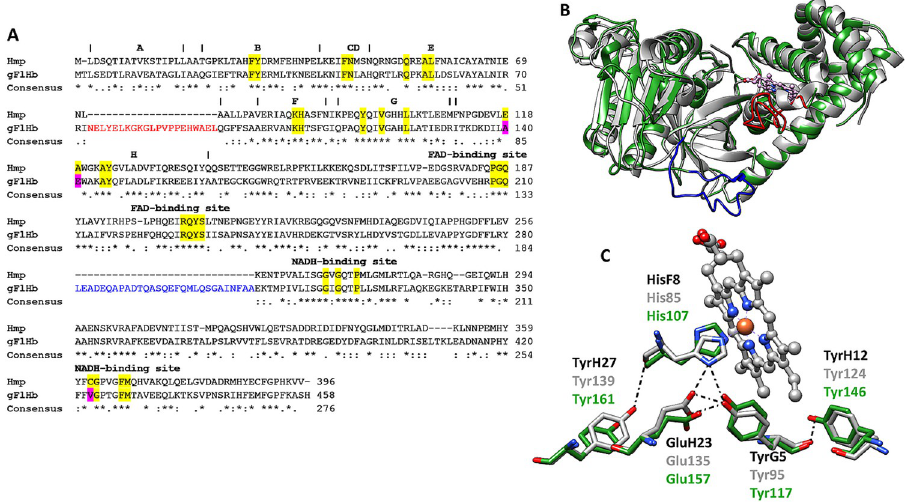
Fig 4. Sequence alignment and protein structure alignment of flavohemoglobins of G . duodenalis (gFlHb) and E . coli (Hmp). (A) Sequence alignment of gFlHb and Hmp. The conserved residues in the heme and the reductase domains are highlighted in yellow and differences present in gFlHb are highlighted in pink. The additional sequence inserts in the globin and FAD domains in gFlHb are highlighted in red and blue, respectively (Rafferty et al. 2010) [30]. Asterisks indicate identical residues, while colons and periods indicate conserved residues. (B) Structural overlap of gFlHb (green) and Hmp (gray; ID PDB: 1GVH). (C) Proximal site of hydrogen bonding pattern of consensus FlHb (black), gFlHb (green) and Hmp